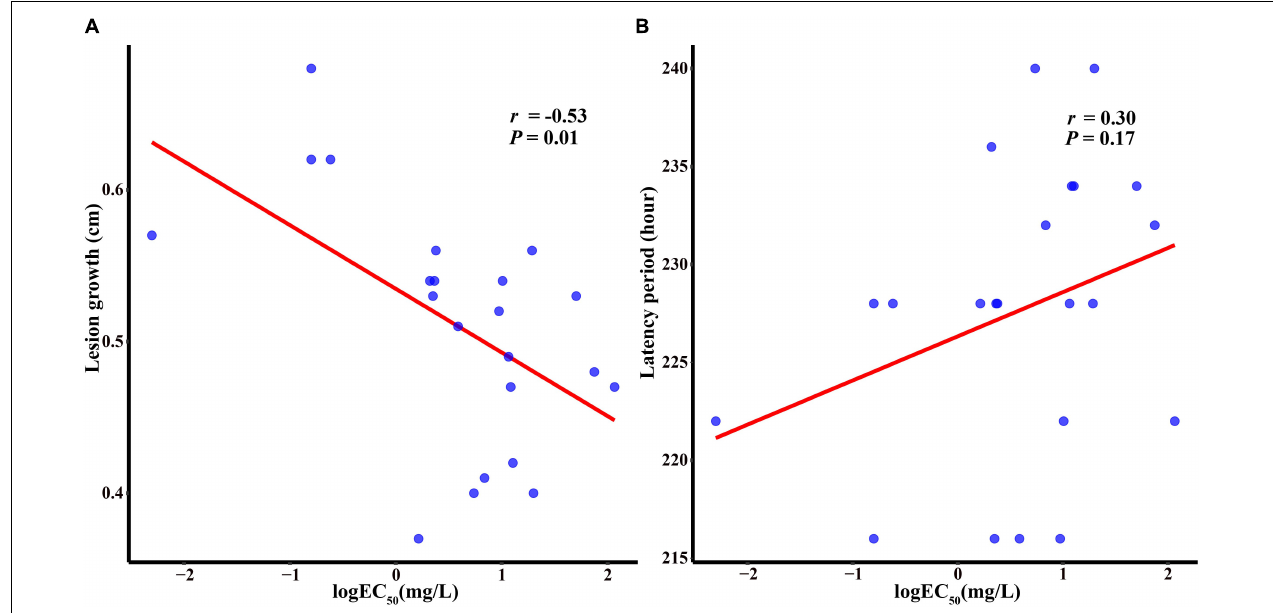
FIGURE 3 | Correlations between the level of sensitivity to triadimefon and length growth (A) and latency period (B)